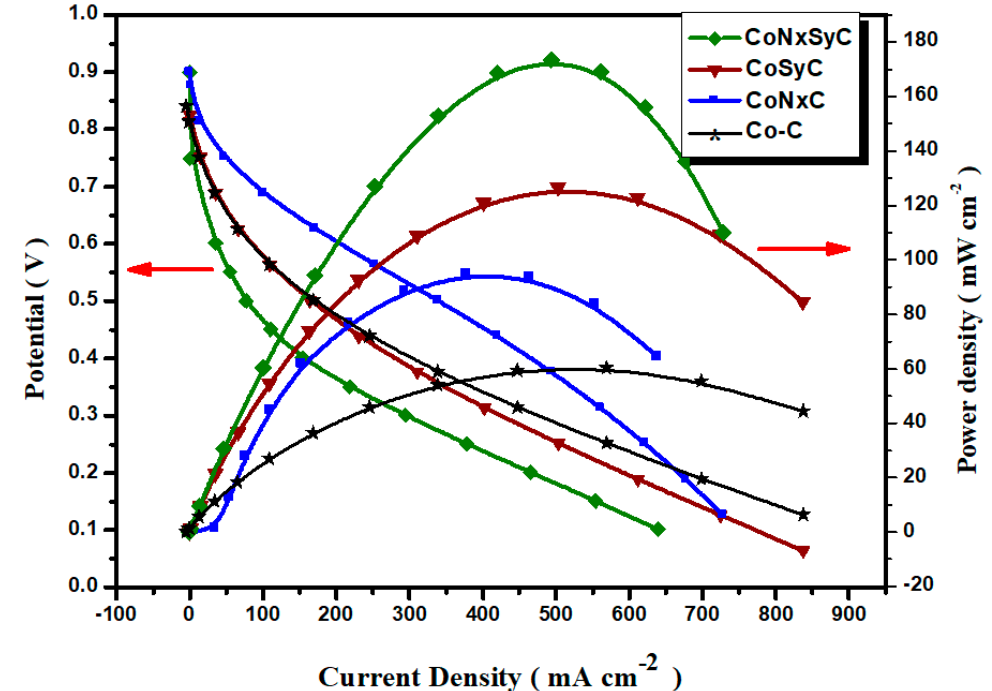
Figure 7. Power and current densities of single cells made of various co-catalyst cathodes.